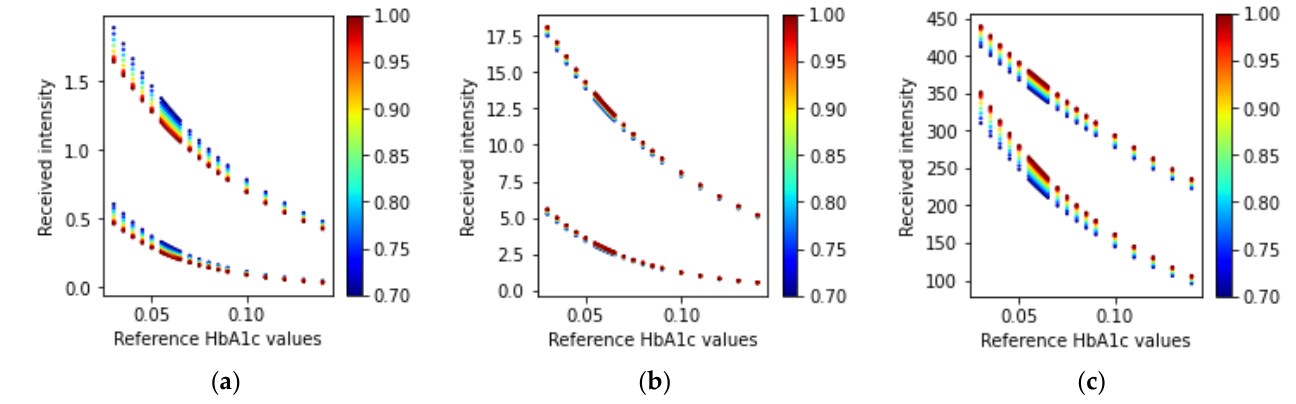
Figure 14. Received intensity values for the three wavelengths ( a ) 465 nm, ( b ) 525 nm, and ( c ) 615 nm. In each scatter plot, the top adjacent points correspond to the diastolic phase and the bottom points correspond to the systolic phase. The color bars at the side of the plots indicate the different SpO 2 values ranging from 70% to 100%.